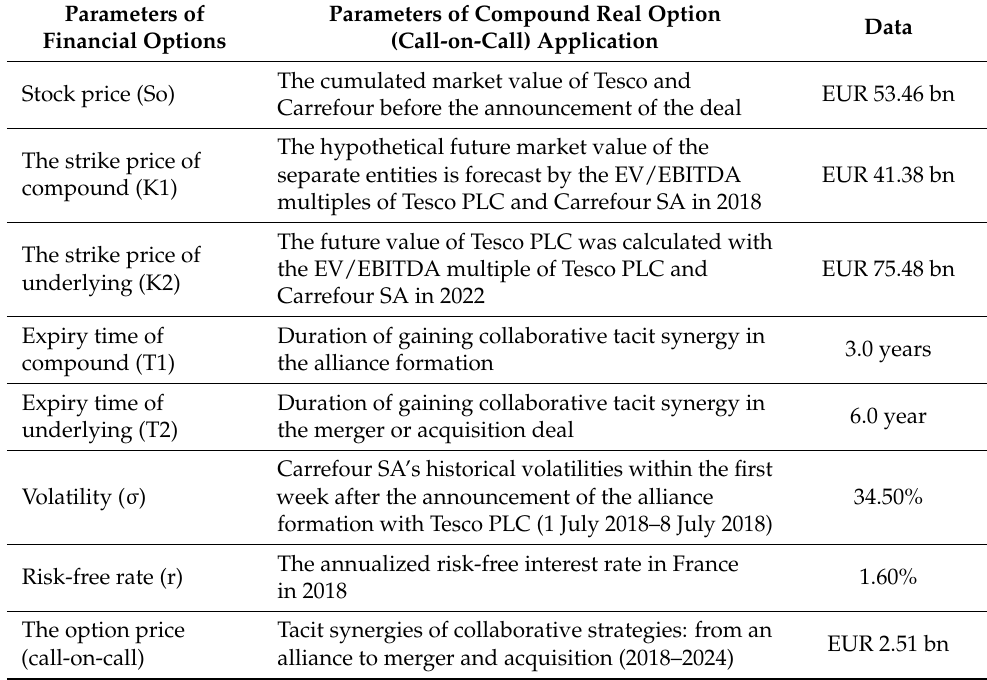
Table 7. Parameters of financial and sequential compound real options: the Tesco and Carrefour